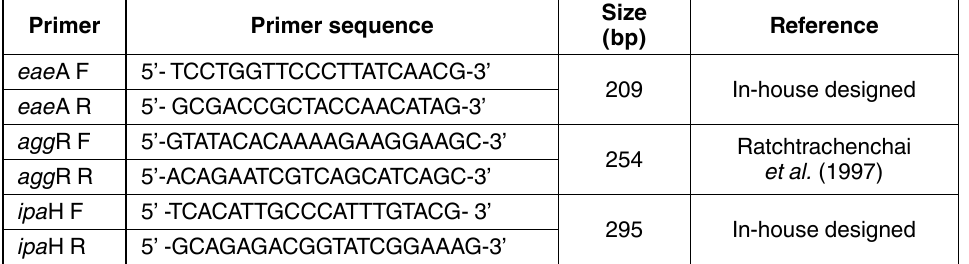
table 2. Primers used for the identification of tet A and tet B genes Primer Primer sequence